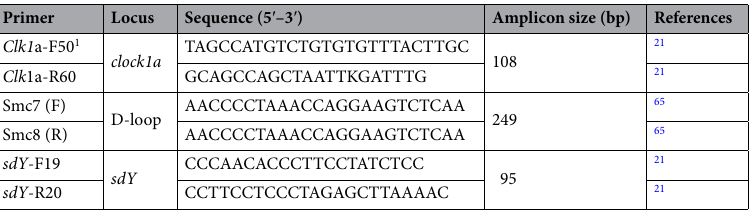
Table 1. Primers used in the PCR sex identification assays. 1 F and R denote forward and reverse primers,